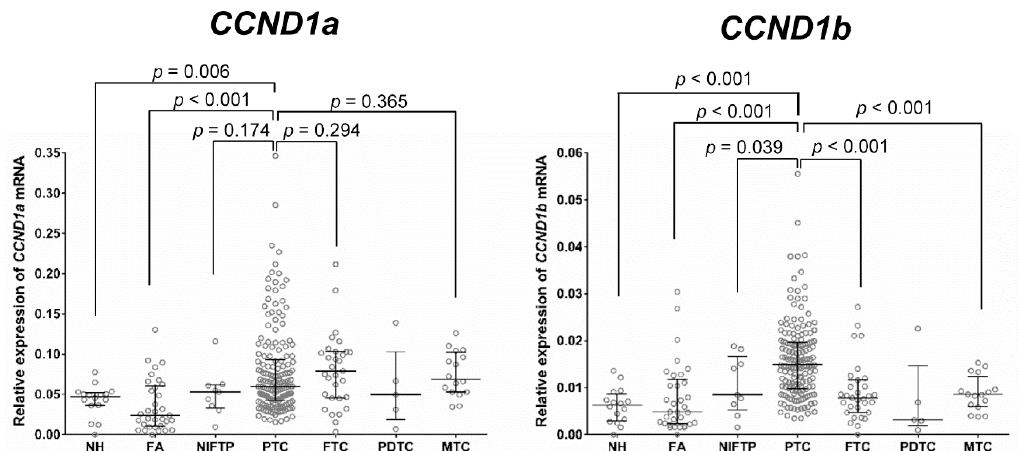
Figure 2. Expression of CCND1 mRNA isoforms relative to that of GAPDH in various types of thyroid tumors. NH, nodular hyperplasia; FA, follicular adenoma; NIFTP, noninvasive follicular thyroid